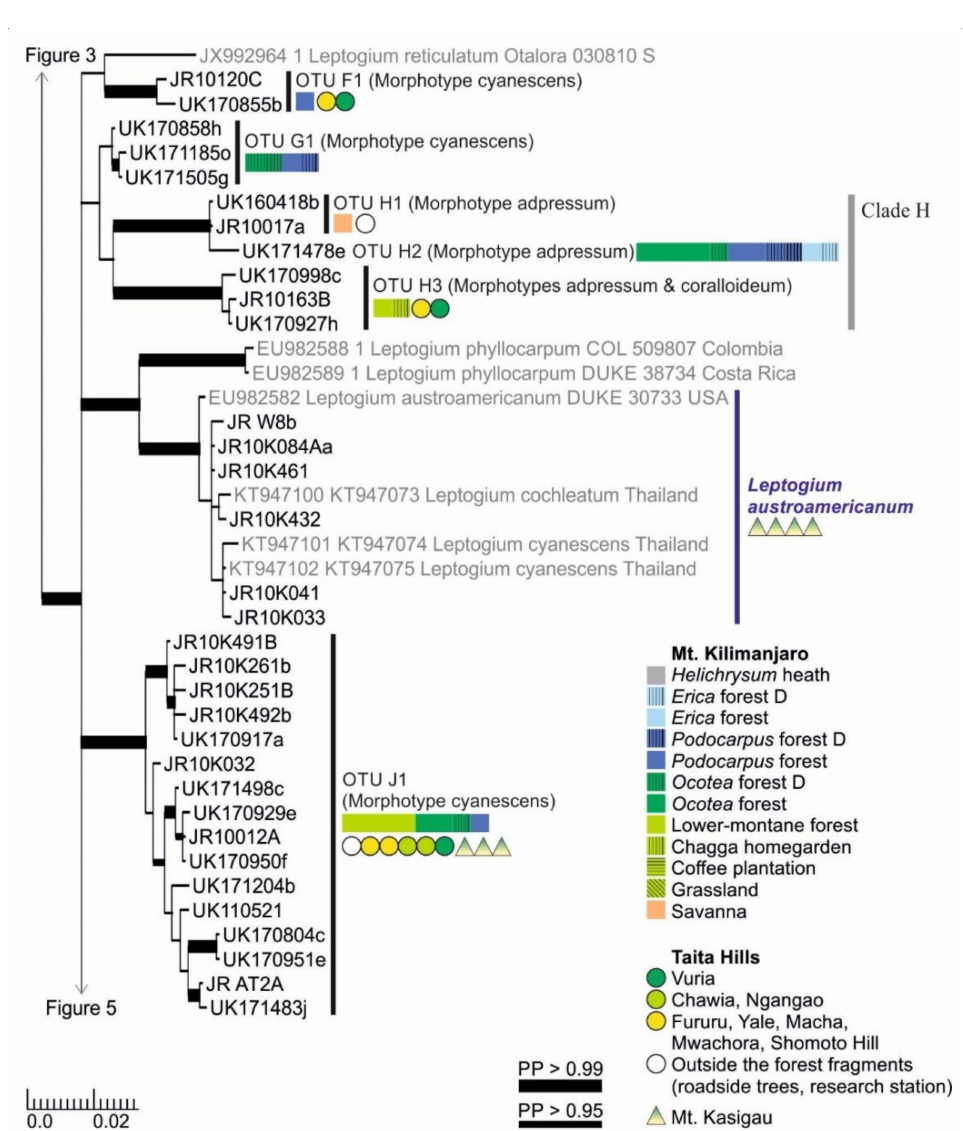
Figure 4. Clades F–J of the Bayesian tree of the genus Leptogium based on the mtSSU and 5.8S marker regions (Figure S2). Newly obtained sequences are in black, including one specimen representing each mtSSU variant; all specimens belonging to each clade are listed in Table S1. Established species are in blue. For more detailed explanation, for example, for the colors and shapes indicating the distribution and abundance of taxa, see the caption of Figure 2. D = disturbed; PP = posterior probability (for the precise values, see Figure